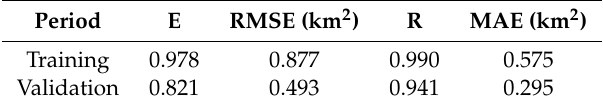
Figure 7. Comparison between observation and simulation of six-monthly SIA using FNN Model 2 : ( a ) line plot of results; ( b ) scatter plot of results. Table 4. Statistical indicators of FNN Model 2 during the training and validation period.